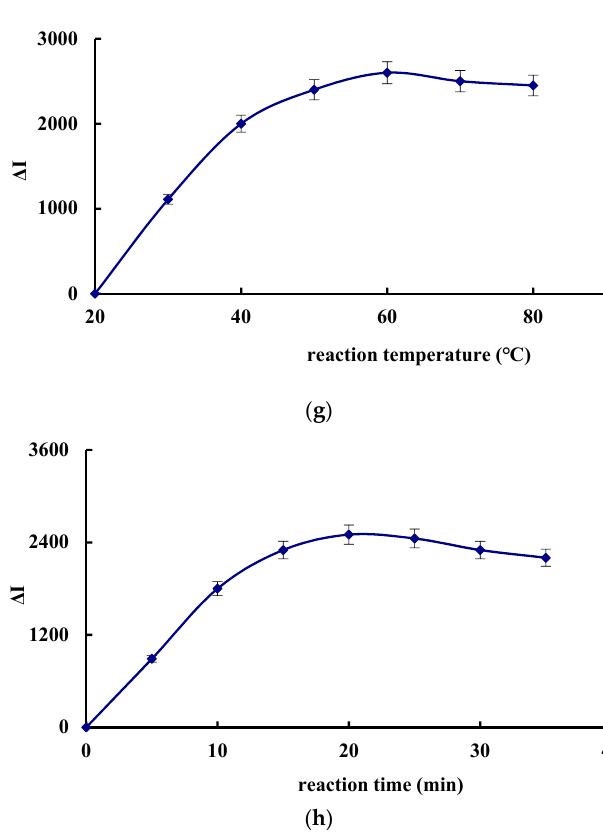
Figure 4. Effect of reagent concentration, reaction temperature and time on Δ I . ( a ) H 2 O 2 , ( b ) DBD, ( c ) CD NAg2 , ( d ) Apt, ( e ) AgNPs, ( f ) pH, ( g ) reaction temperature, and ( h ) reaction time.